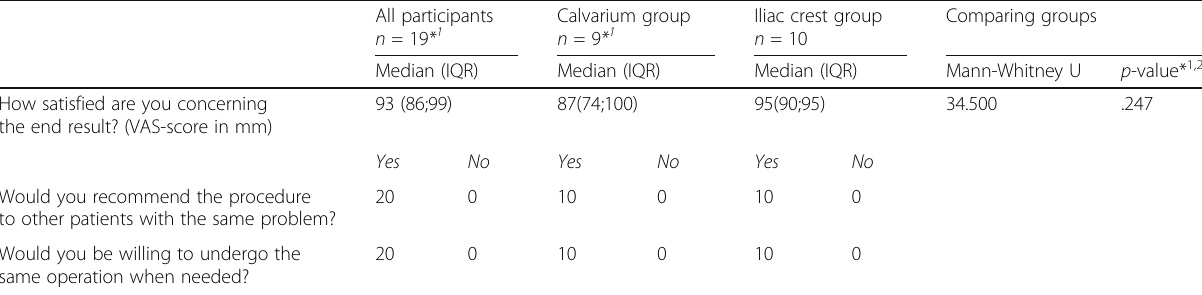
Table 4 General satisfaction: results for all participants and per group